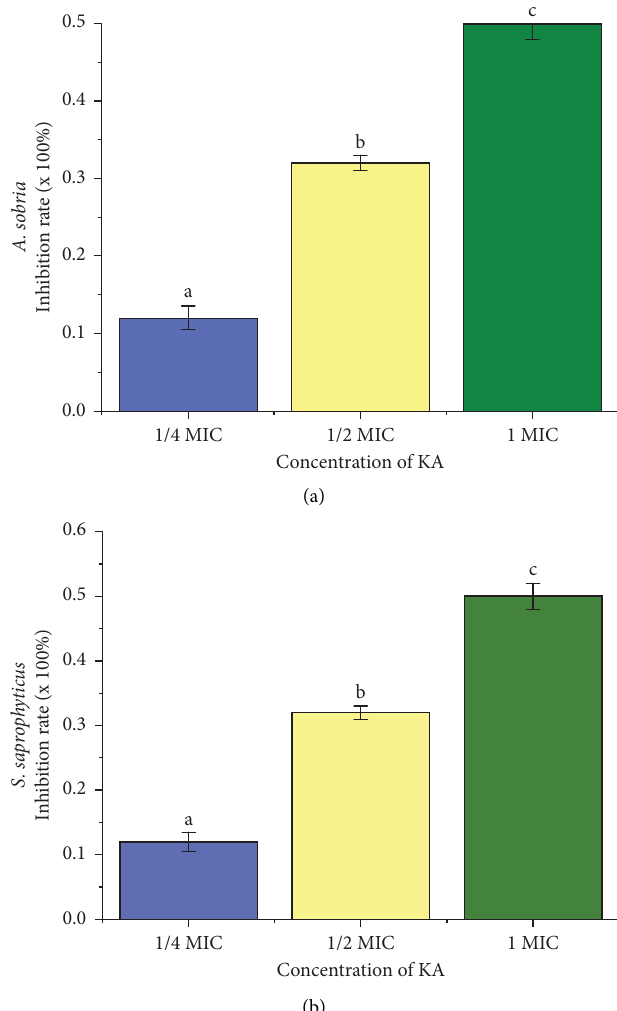
Figure 4: Inhibition efect on the metabolic activity of bioflms of A. sobria (a) and S. saprophyticus (b) after KA treatment at diferent densities at 30 ° C for 24h. Values are exhibited as the percentage of the metabolic activity of bioflms. Te diferent lowercase letters represent signifcant diferences ( P <